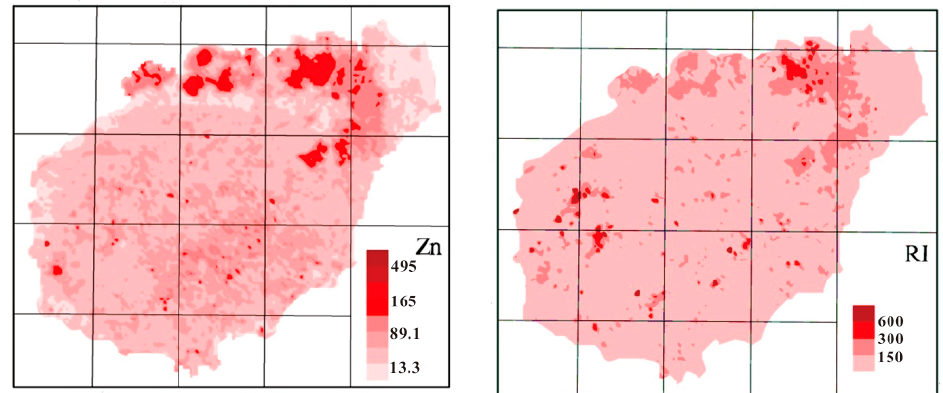
Figure 3. Spatial distribution of As, Cu, Cr, Pb, Ni, Se, Zn (mg kg − 1 ), Cd, and Hg ( μ g kg − 1 ) and risk index (RI) in soils of Hainan Island.